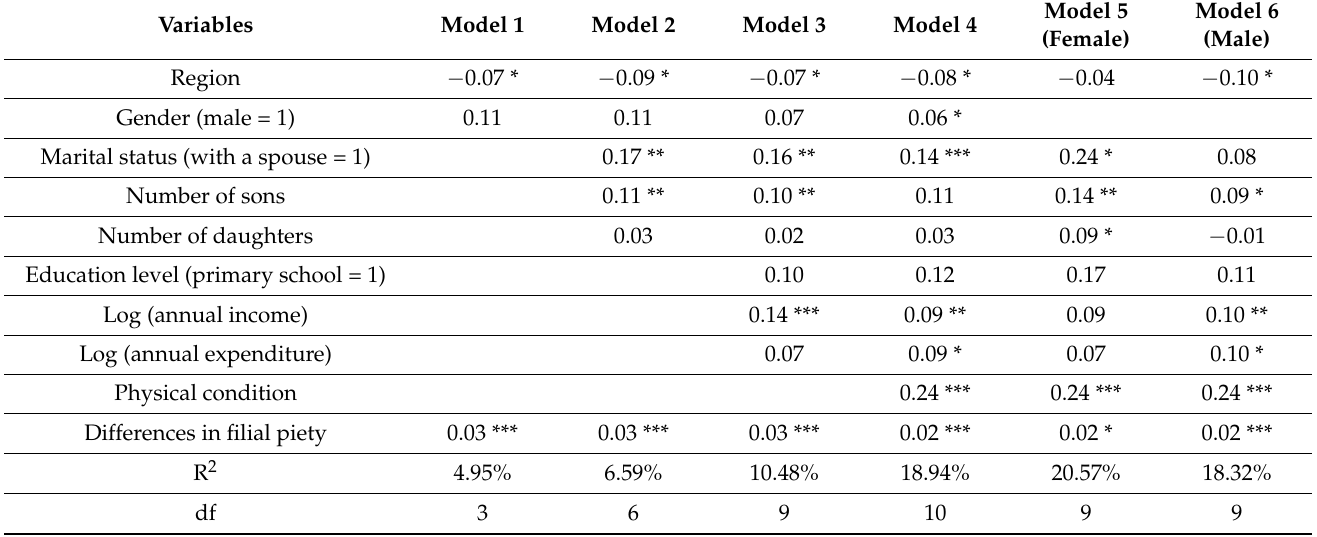
Table 5. Relationship between differences in filial piety and life satisfaction of empty-nest elderly in rural